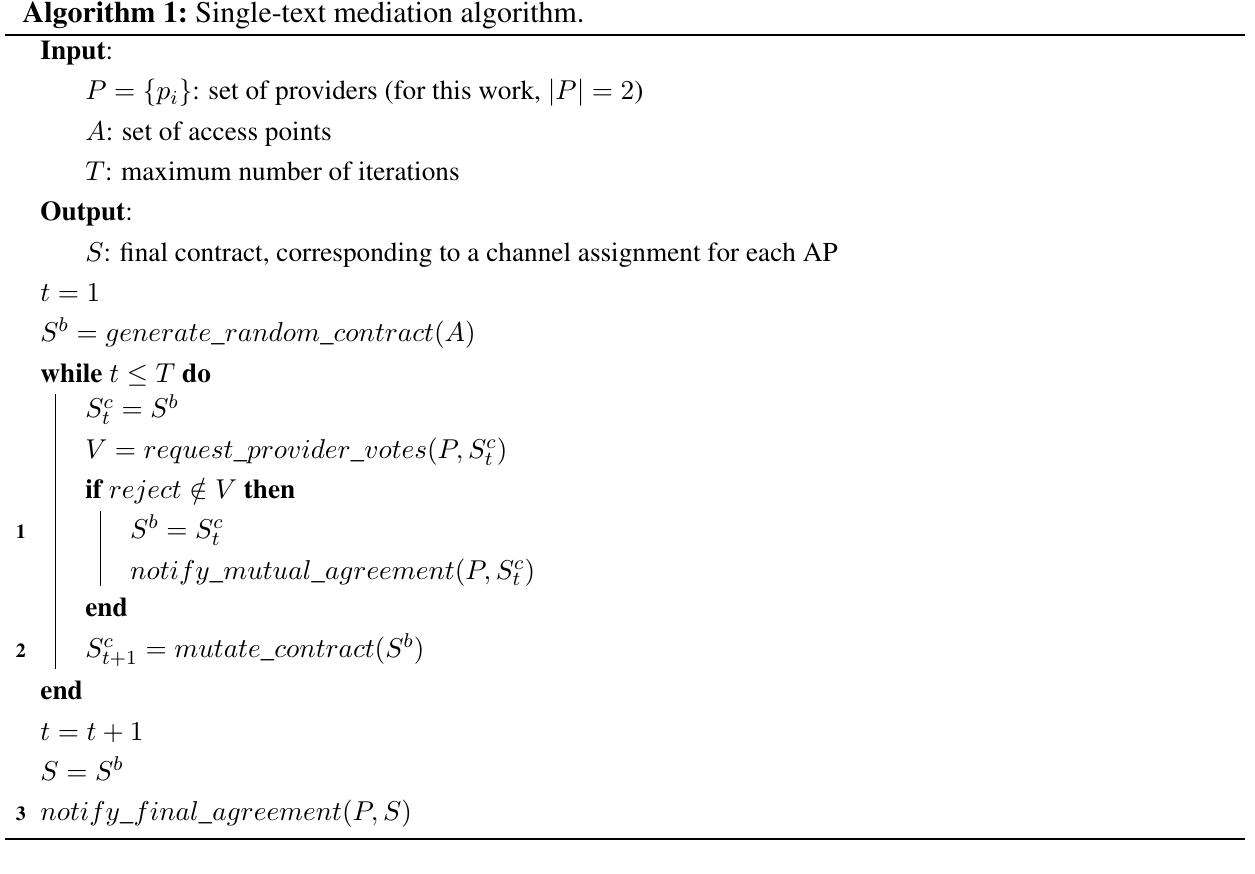
Algorithm 2: Hill-climber voting